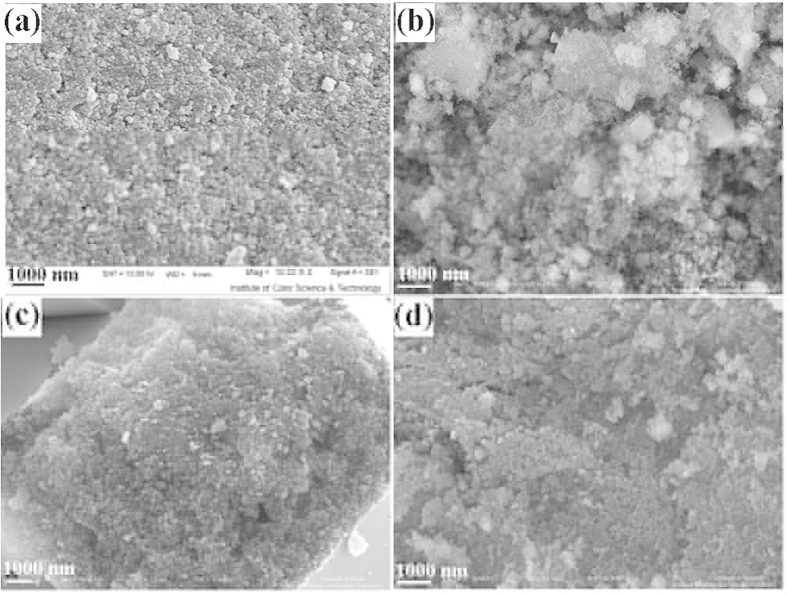
(a) FT-IR spectrum, (b) EDS pattern, and (c) PL spectrum of ZnCr2O4 (sample 4).